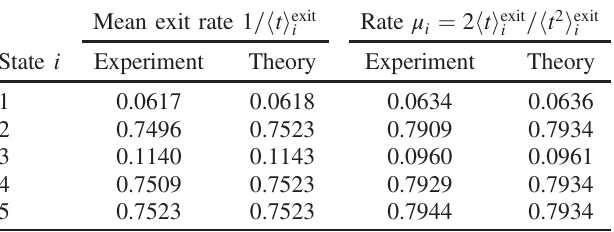
TABLE IV. Mean versus asymptotics. Each “ experimental ” 4 × 10 5 simulated exits from each value is deduced from N sim ¼ state generated by the stochastic Milstein scheme with Δ t ¼ 10 − 4 . The “ theory ” values are obtained from a numerical evaluation of the results in Sec. II D [see also Eqs. (S47) and (S50) in the Supplemental Material [75]]. Each experimental ffiffiffiffiffiffiffiffiffi p ≈ 0 . 0016 N value has a relative statistical error of about 1 = sim